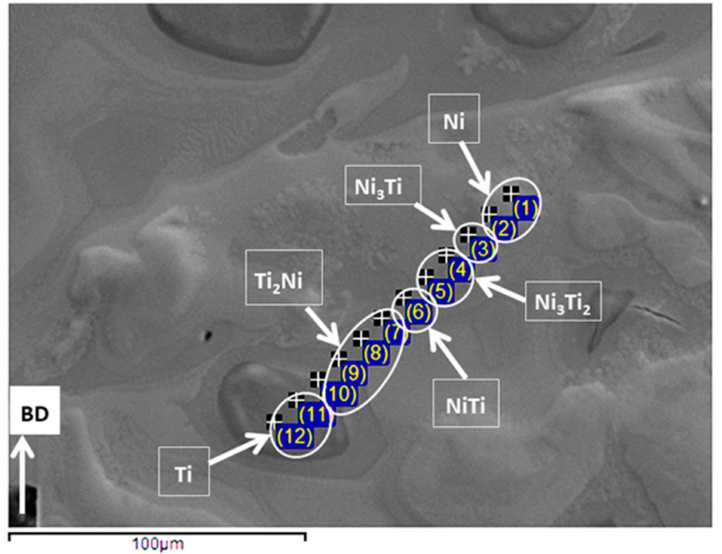
Figure 6. Results of EDS elemental ratio studies conducted on samples printed by set 4 and processed from 60 wt.% Ni + 40 wt.% Ti powder